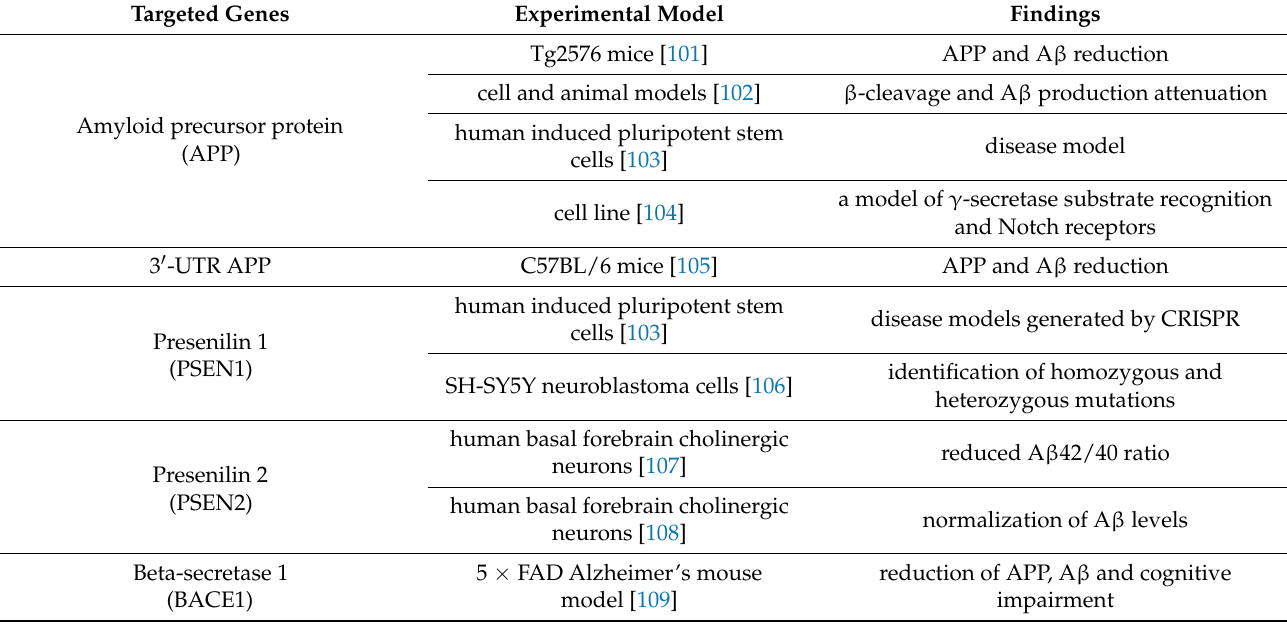
Table 1. Alzheimer’s disease therapeutics using the CRISPR–Cas9